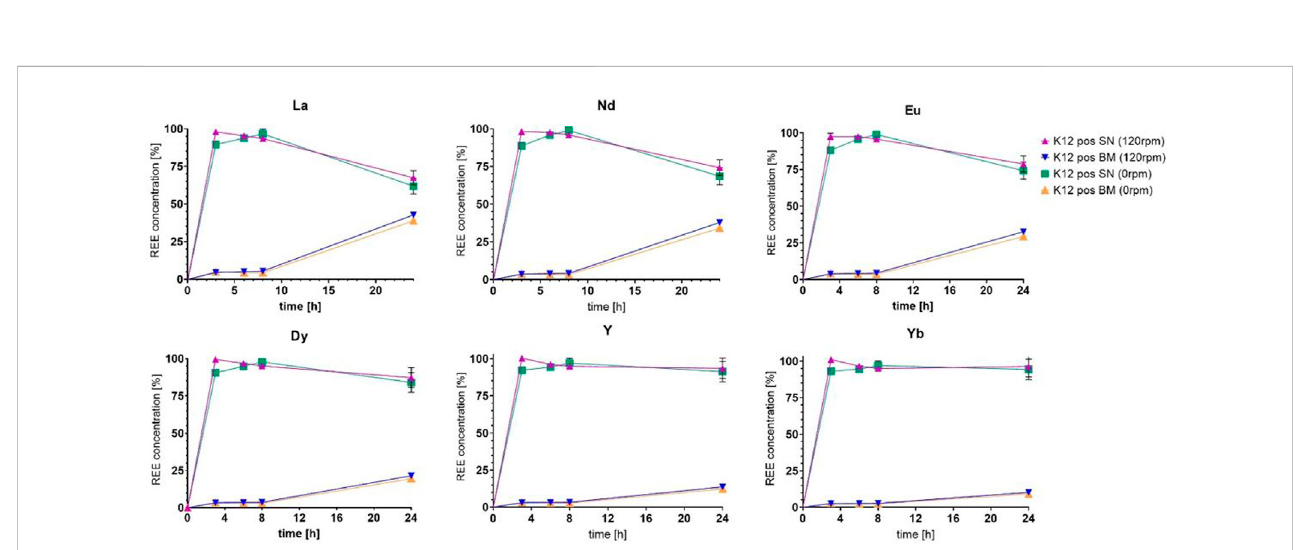
FIGURE 3 Comparison oftheuptakeofsixchosenelements astherepresentation ofthefullsetoflanthanides (concentrationsgiven asapercentage of2.25